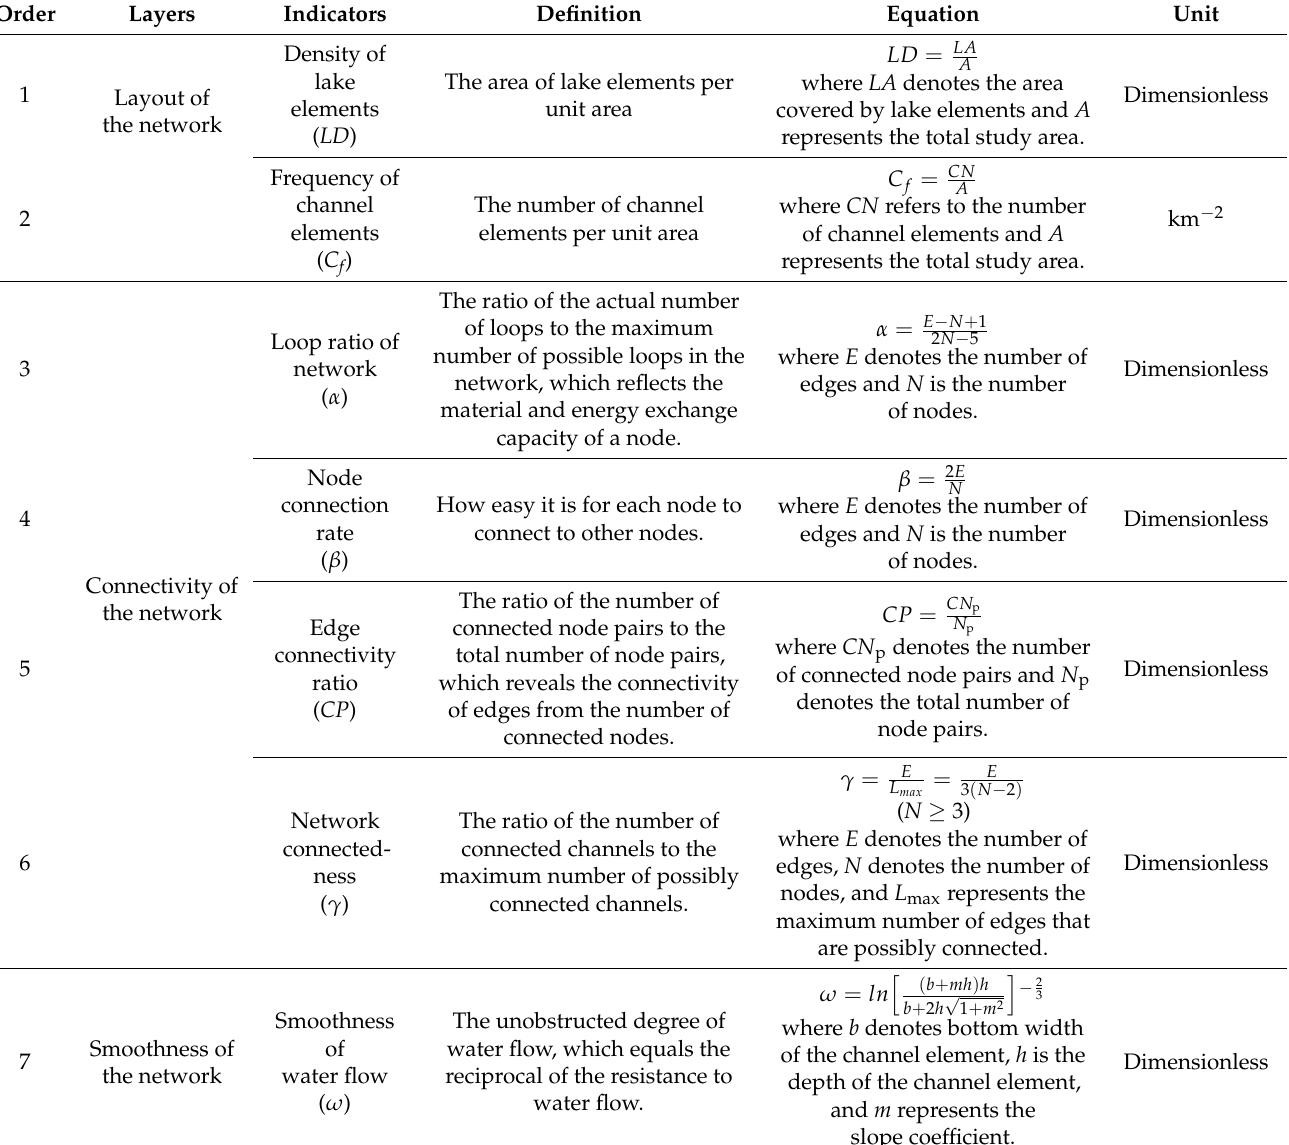
Table 2. Structural connectivity evaluation